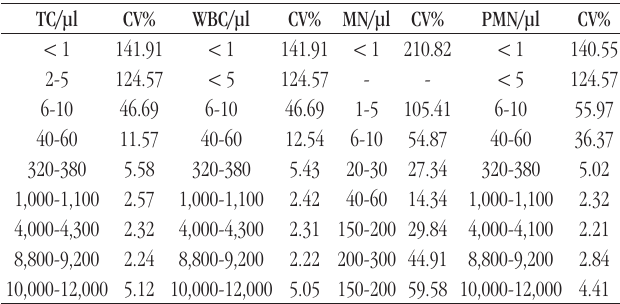
taBLE 2 − Results of precision expressed as CV of Sysmex XE-5000 for TC, WBC,